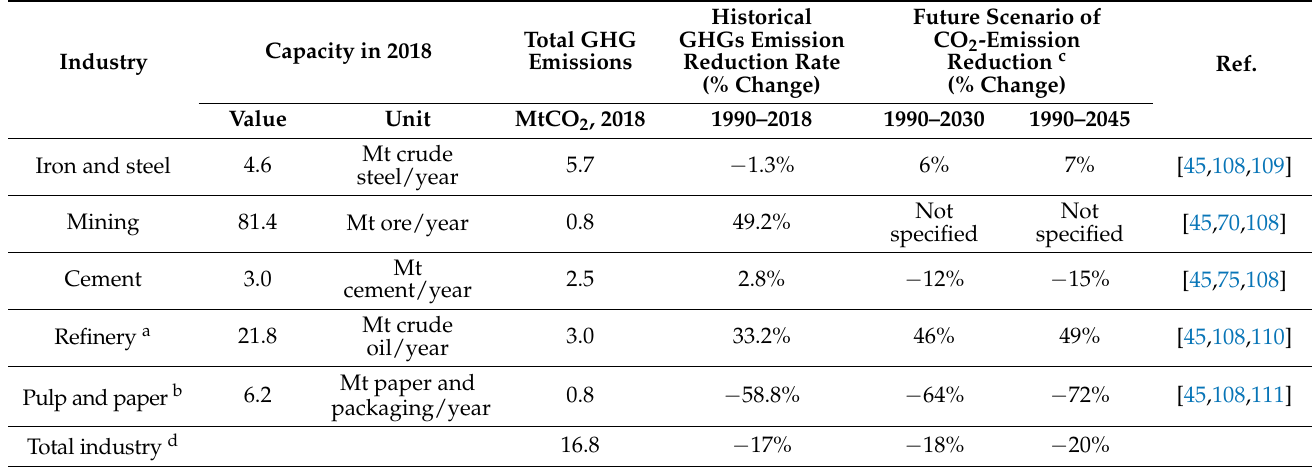
Table 4. The characteristics of several Swedish EIIs along with their historical and future CO 2 emissions reductions.